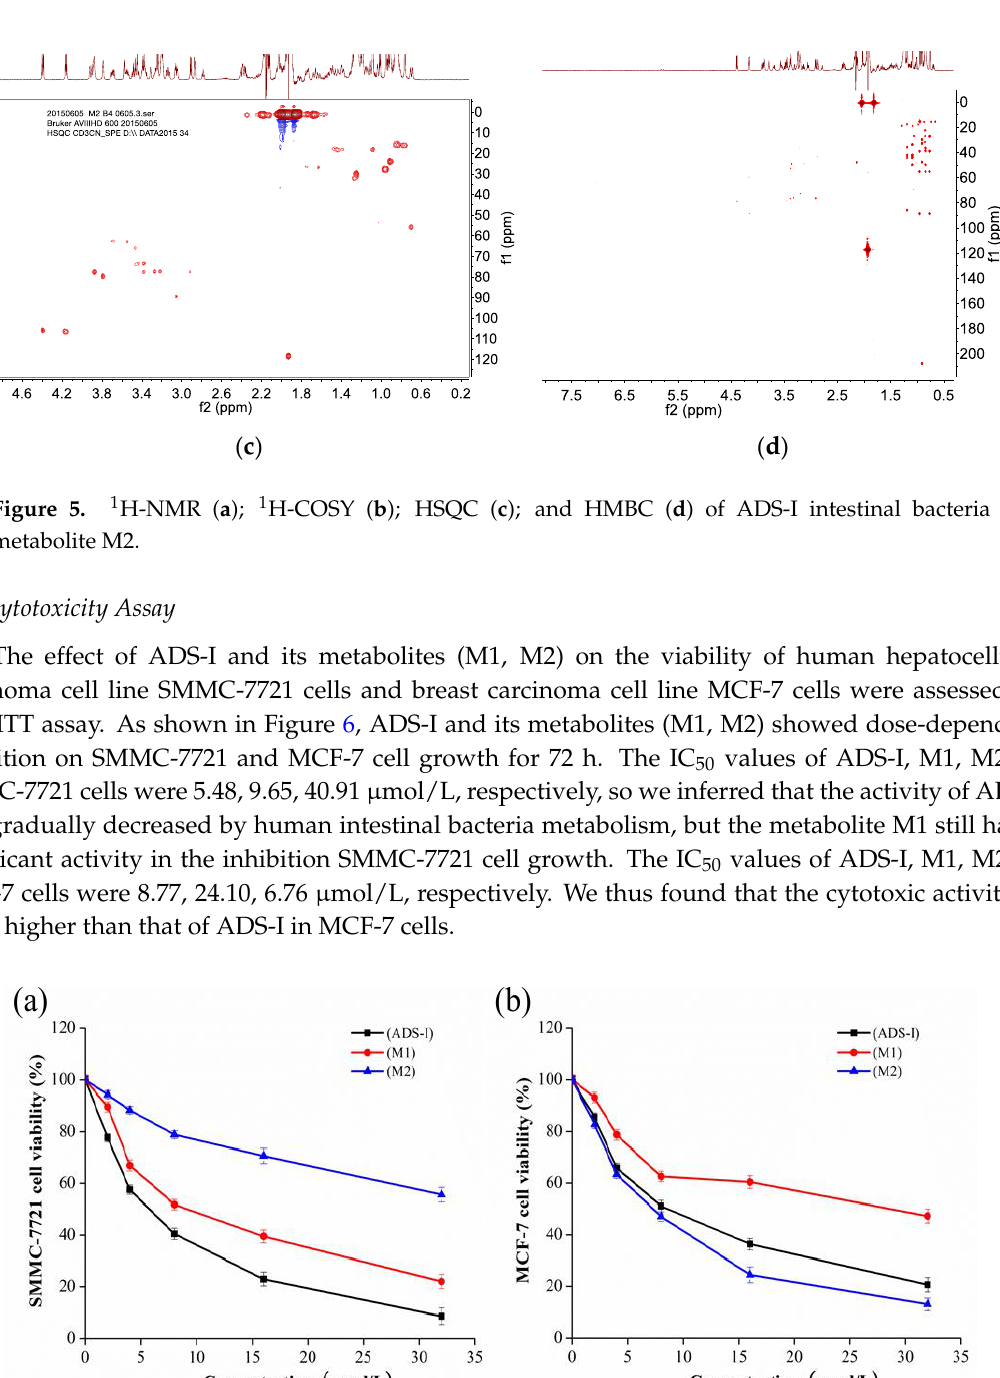
Figure 6. Effect of ADS-I and its metabolites (M1, M2) on the cell viability of human carcinoma cells. ( a ) Viability of the human hepatocellular carcinoma cell line SMMC-7721 cells treated by different concentrations of ADS-I and its metabolites (M1, M2) for 72 h; ( b ) Viability of the human breast carcinoma cell line MCF-7 cells treated by different concentrations of ADS-I and its metabolites (M1, M2) for 72 h. Values are expressed as means ± SD ( n = 3).